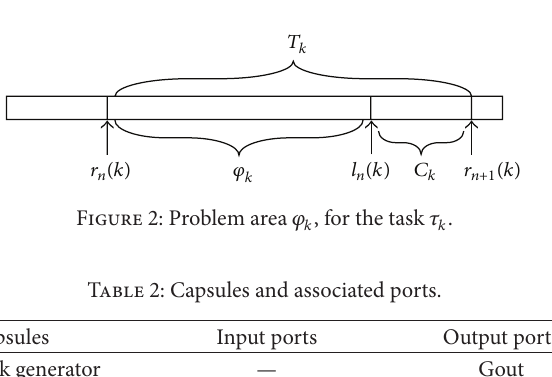
Figure 1: Structure diagram for the model proposed in UML-RT.